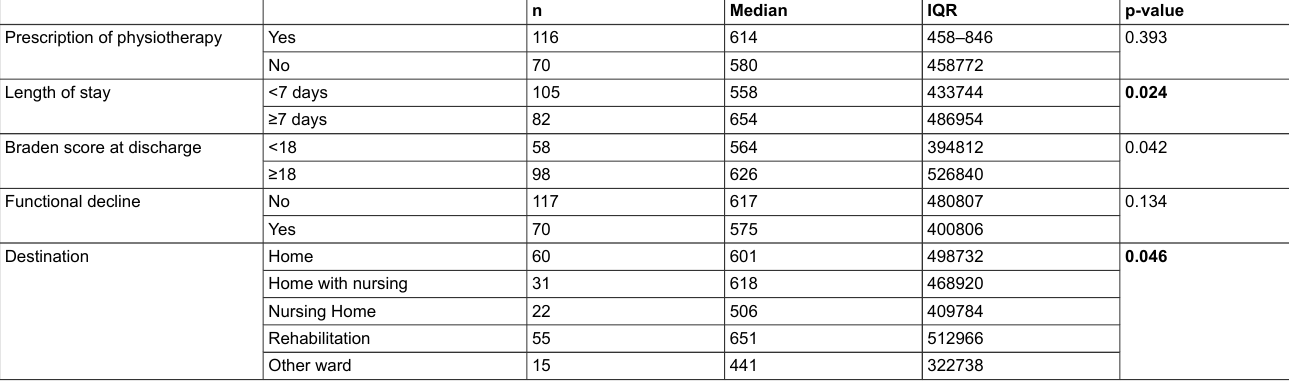
Table 3: Median steps per day for a selection of hospital-related factors and discharge characteristics of the study sample.